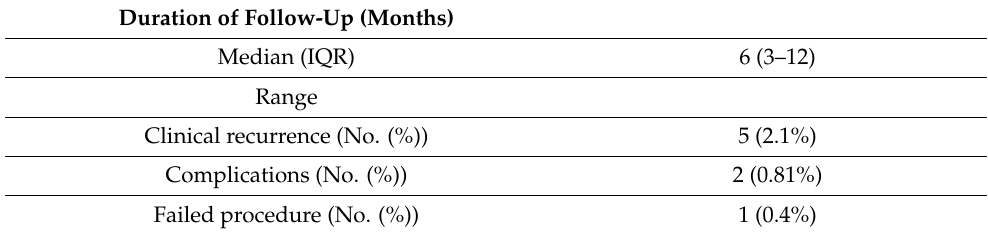
Table 2. Postoperative characteristics of the study cohort (No. = 251).